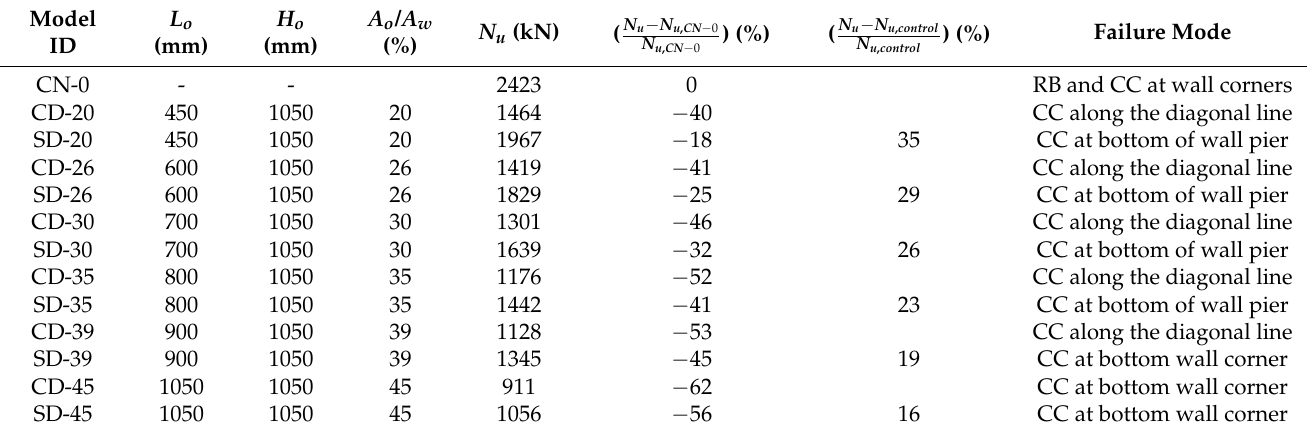
Table 3. Results of wall models with various opening sizes.